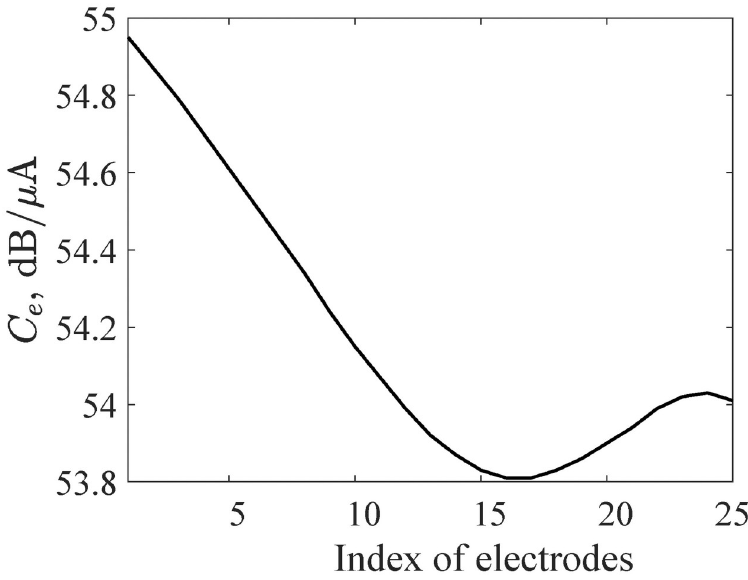
Fig 7. Current levels, C , for which 20% of auditory nerve fibers generates action potentials. A 25-electrode array is e used in this example.